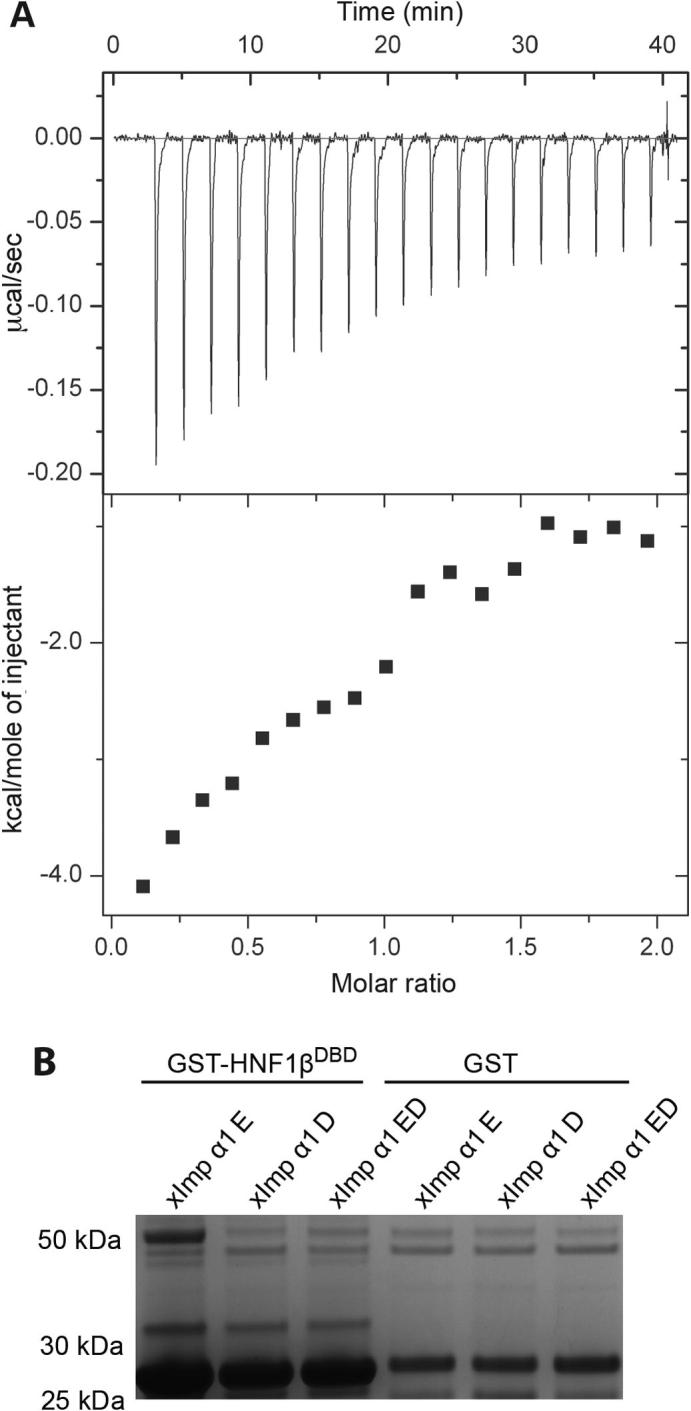
(A) ITC titration for the binding of the HNF1β NLS peptide to ΔIBB mImportin-α1. Fitting the data (with χ2/DoF = 2.9 × 104) gave a Kd of 13.6 ± 1.5 nM for 0.94 ± 0.13 sites, ΔH = −7.2 ± 1.6 kcal/mol, ΔS = −1.7 cal/mol/deg. (B) In pull-down assays, GST-HNF1β bound only the E mutant of ΔIBB Xenopus Importin-α1 (that impairs NLS binding at the minor site) Mr 50 kD, but not the D mutant (that impairs binding at the major site) or ED double mutant (see Giesecke and Stewart, 2010).